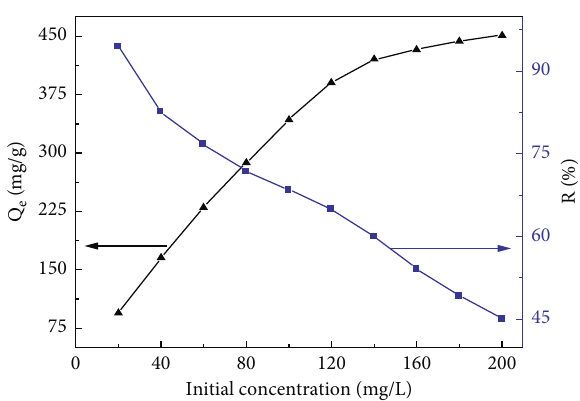
Figure 11: The effects of different initial concentrations of Cr(VI) on the removal of Cr(VI) by the PPy/Fe 3 O 4 nanotubes